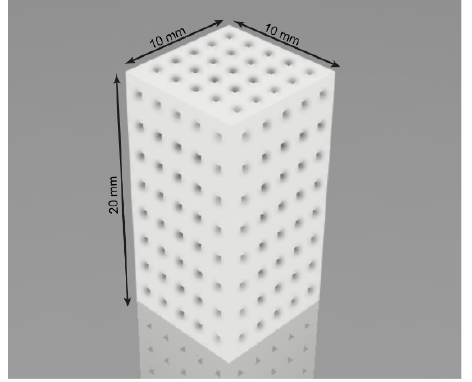
Figure 1. Three dimensional model of a scaffold with interconnected pores 600 µ m. The diameter of the filaments used for FDM 3D printing of the samples was 1.5 ± 0.3 mm. BiZon Prusa i3 Steel PRO (3DiY, Russia) was employed for 3D printing of the scaffolds.